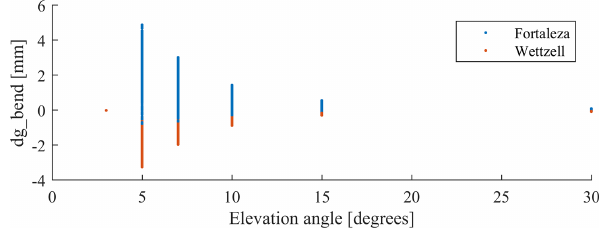
Figure A1. The unmodeled geometric bending effect in VMF1 hydrostatic mapping function (d g bend ), as an example for VLBI sites in Fortaleza, Brazil, and Wettzell, Germany. Analyzed period: January–February 2014. In the case of ε = 3 ◦ , almost no bending error is visible since mf h (ε) was tuned for this elevation angle. However, for other elevation angles, the unmodeled geometric bending is about 3 % of the slant hydrostatic delay, e.g., up to ± 5 mm at a 5 ◦ elevation angle. In the case of Wettzell, d g bend (ε,α) is mostly negative; i.e., the mapped SHD is smaller than the observed SHD, and vice versa for Fortaleza. So far, these small variations have been neglected when using the VMF1 hydrostatic mapping function in GNSS signal